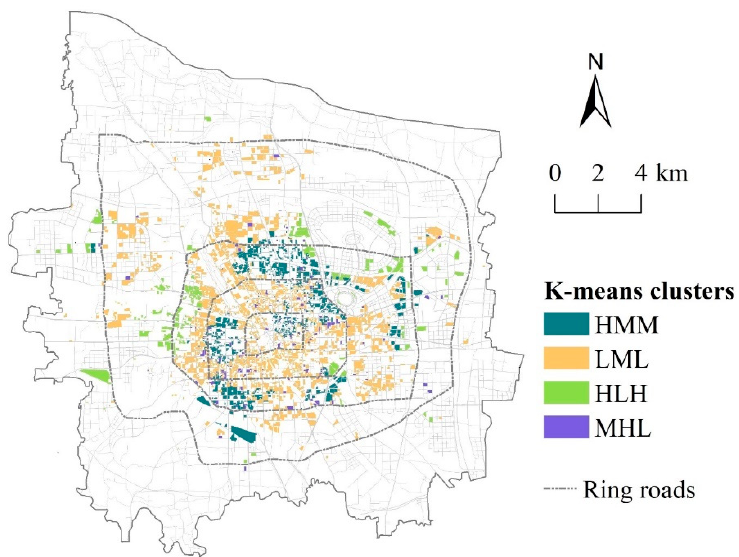
Figure 7. Neighborhood clusters in terms of supply, demand, and accessibility (based on accessibility, average travel time, population density, total park size, and total park quality index).